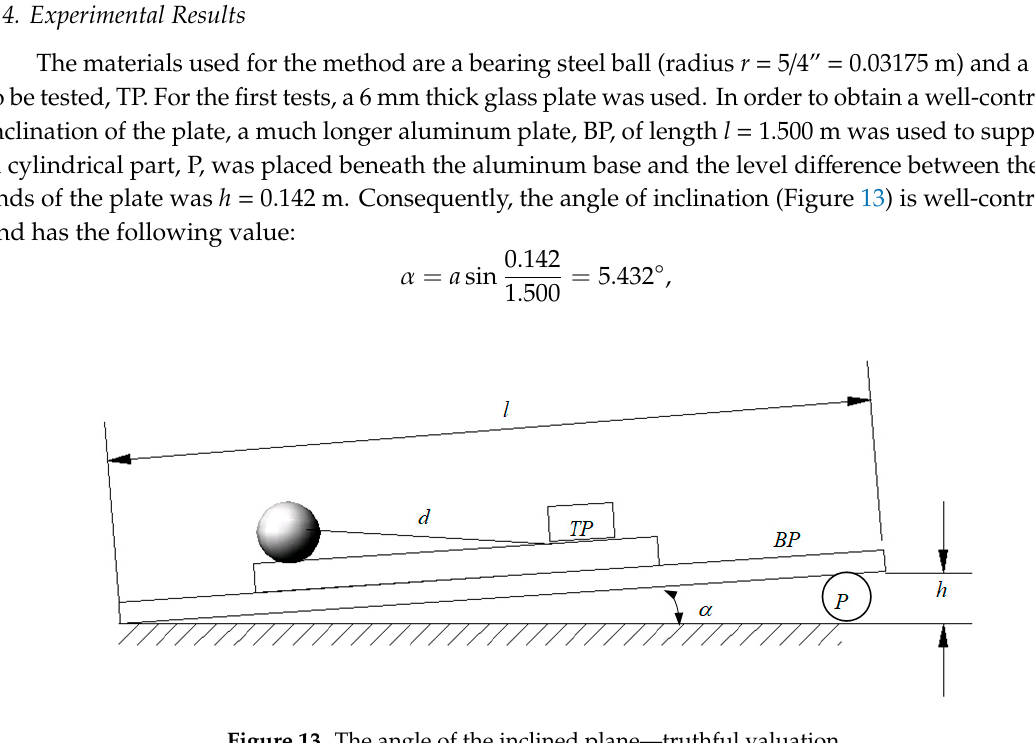
Figure 13. The angle of the inclined plane—truthful valuation.